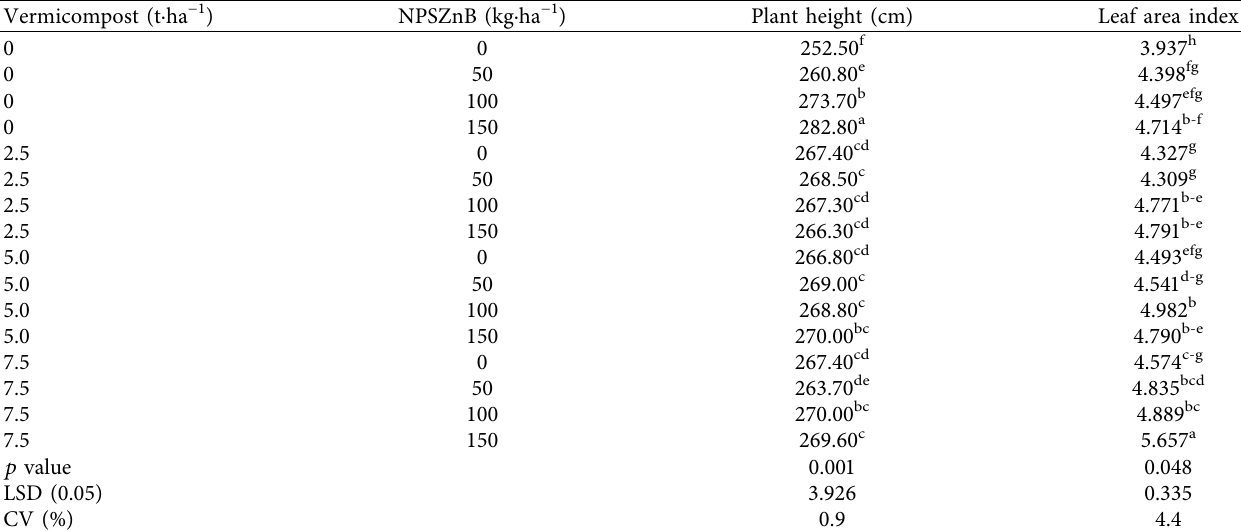
Table 4: Interaction efect of vermicompost levels and inorganic NPSZnB fertilizer rates on plant height (cm) and leaf area index (LAI) of maize in Guto Gida, Western